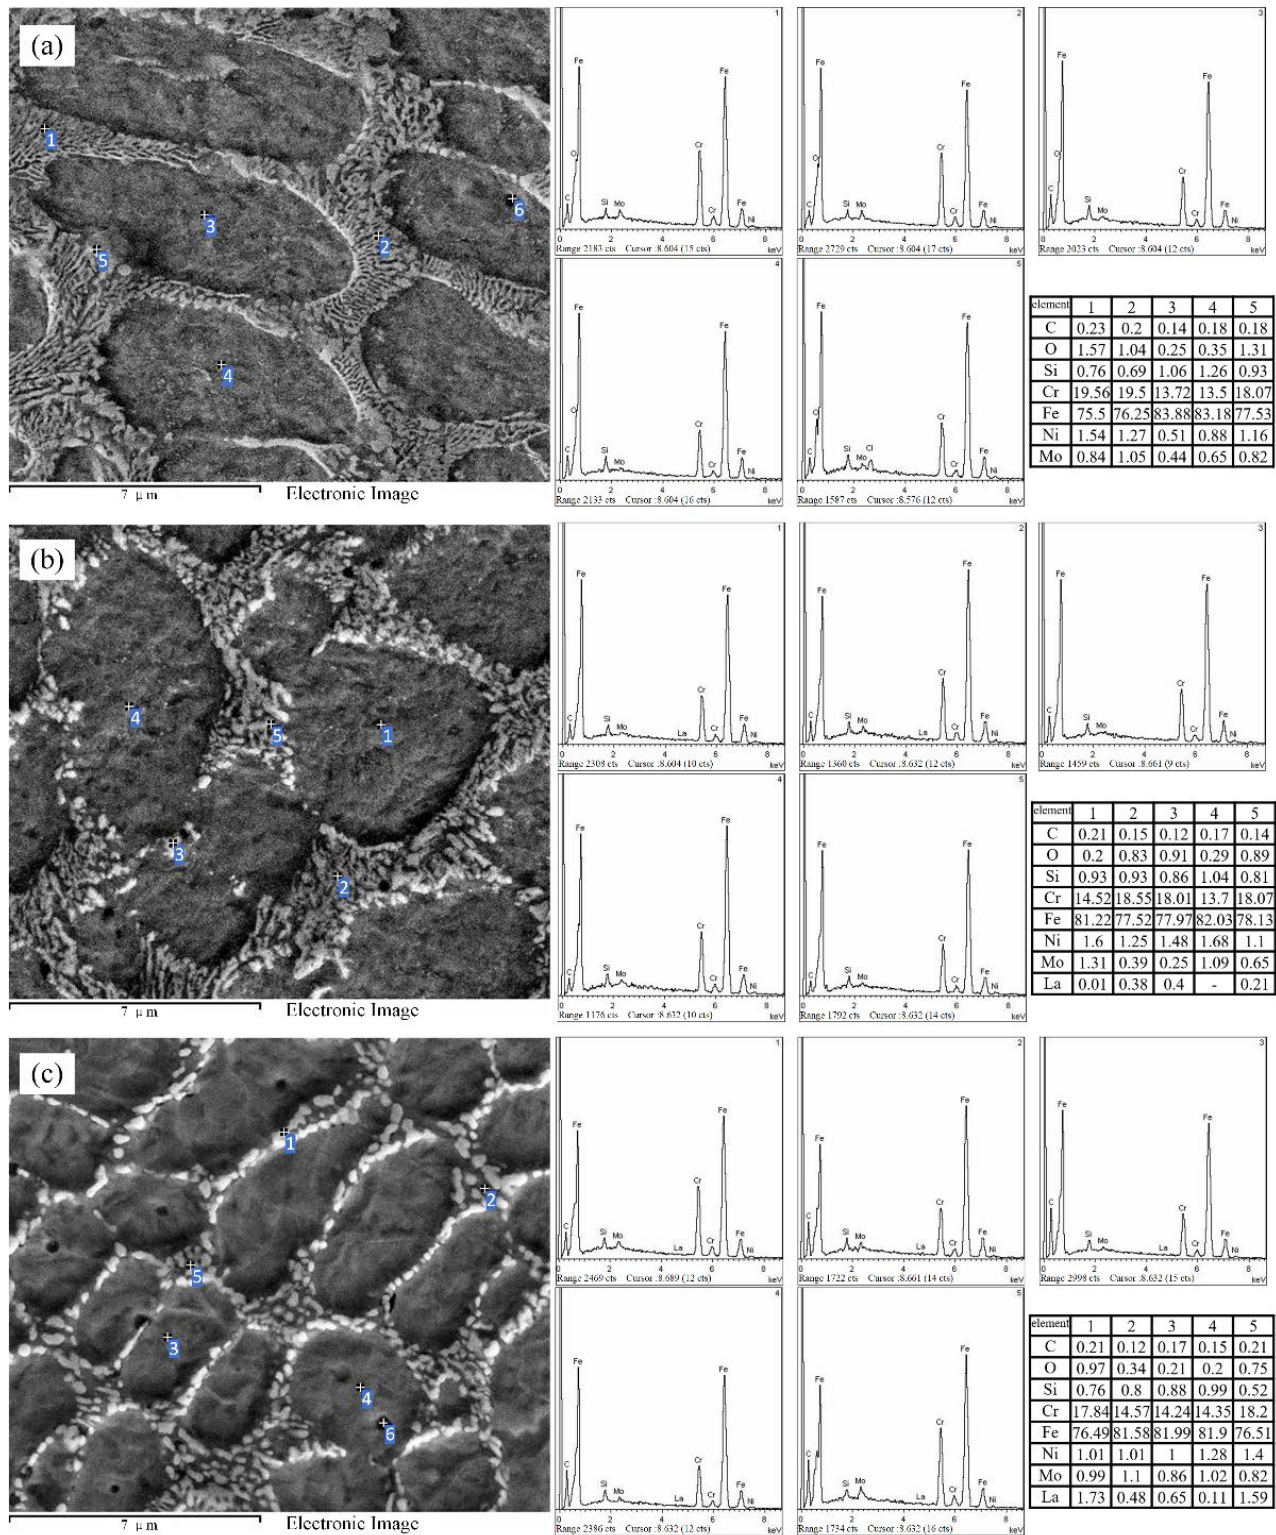
Figure 7. AM alloy point scan EDS curve ( a ) Specimen-0, ( b ) Specimen-1, ( c ) Specimen-4. EDS point scanning.